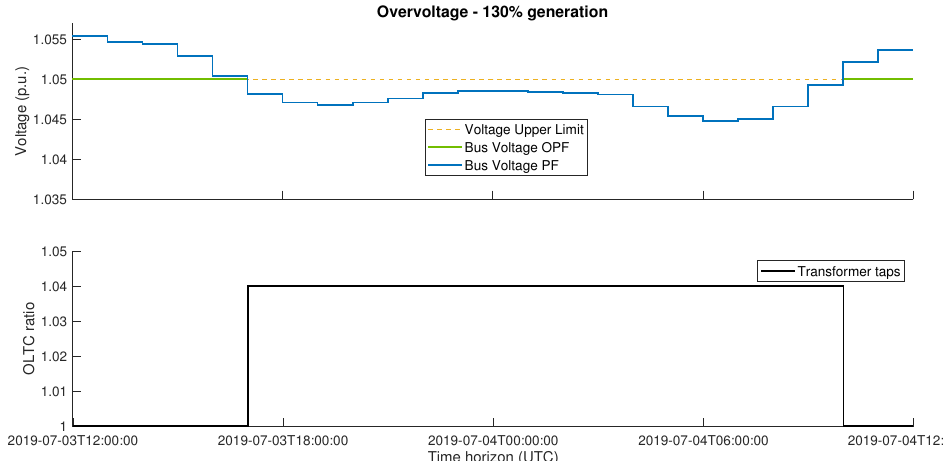
Figure 7. MPOPF impact on the voltage profile of a busbar and the corresponding control-actions (30% generation